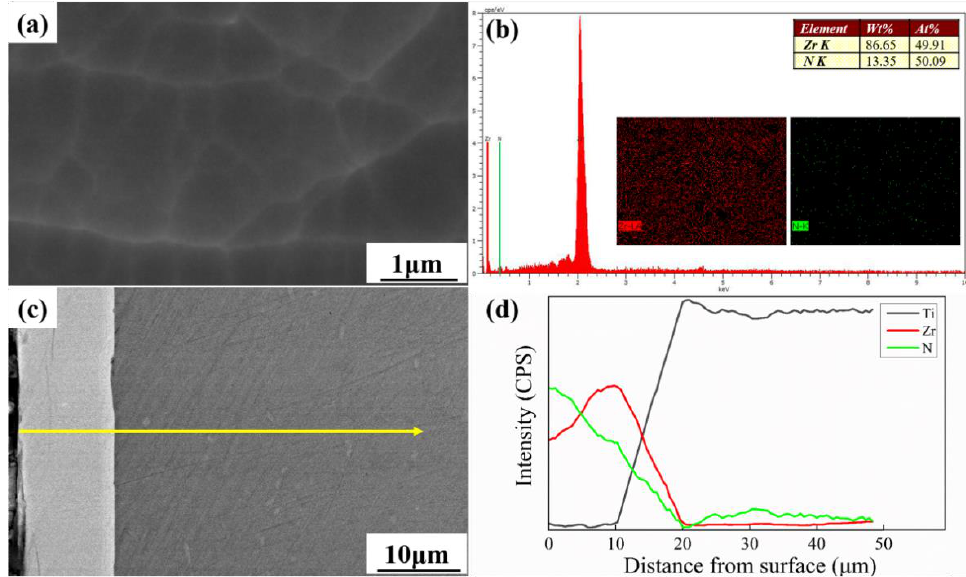
Figure 1. ( a , b ) Surface morphology SEM images and EDS analyses of ZrN coating; ( c , d ) cross-sectional morphology SEM images and EDS analyses of ZrN coating.